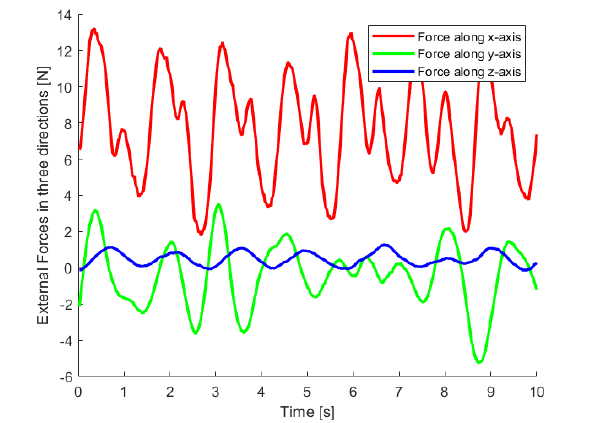
Figure 19. An example of external disturbances generated by a propeller fixed to the